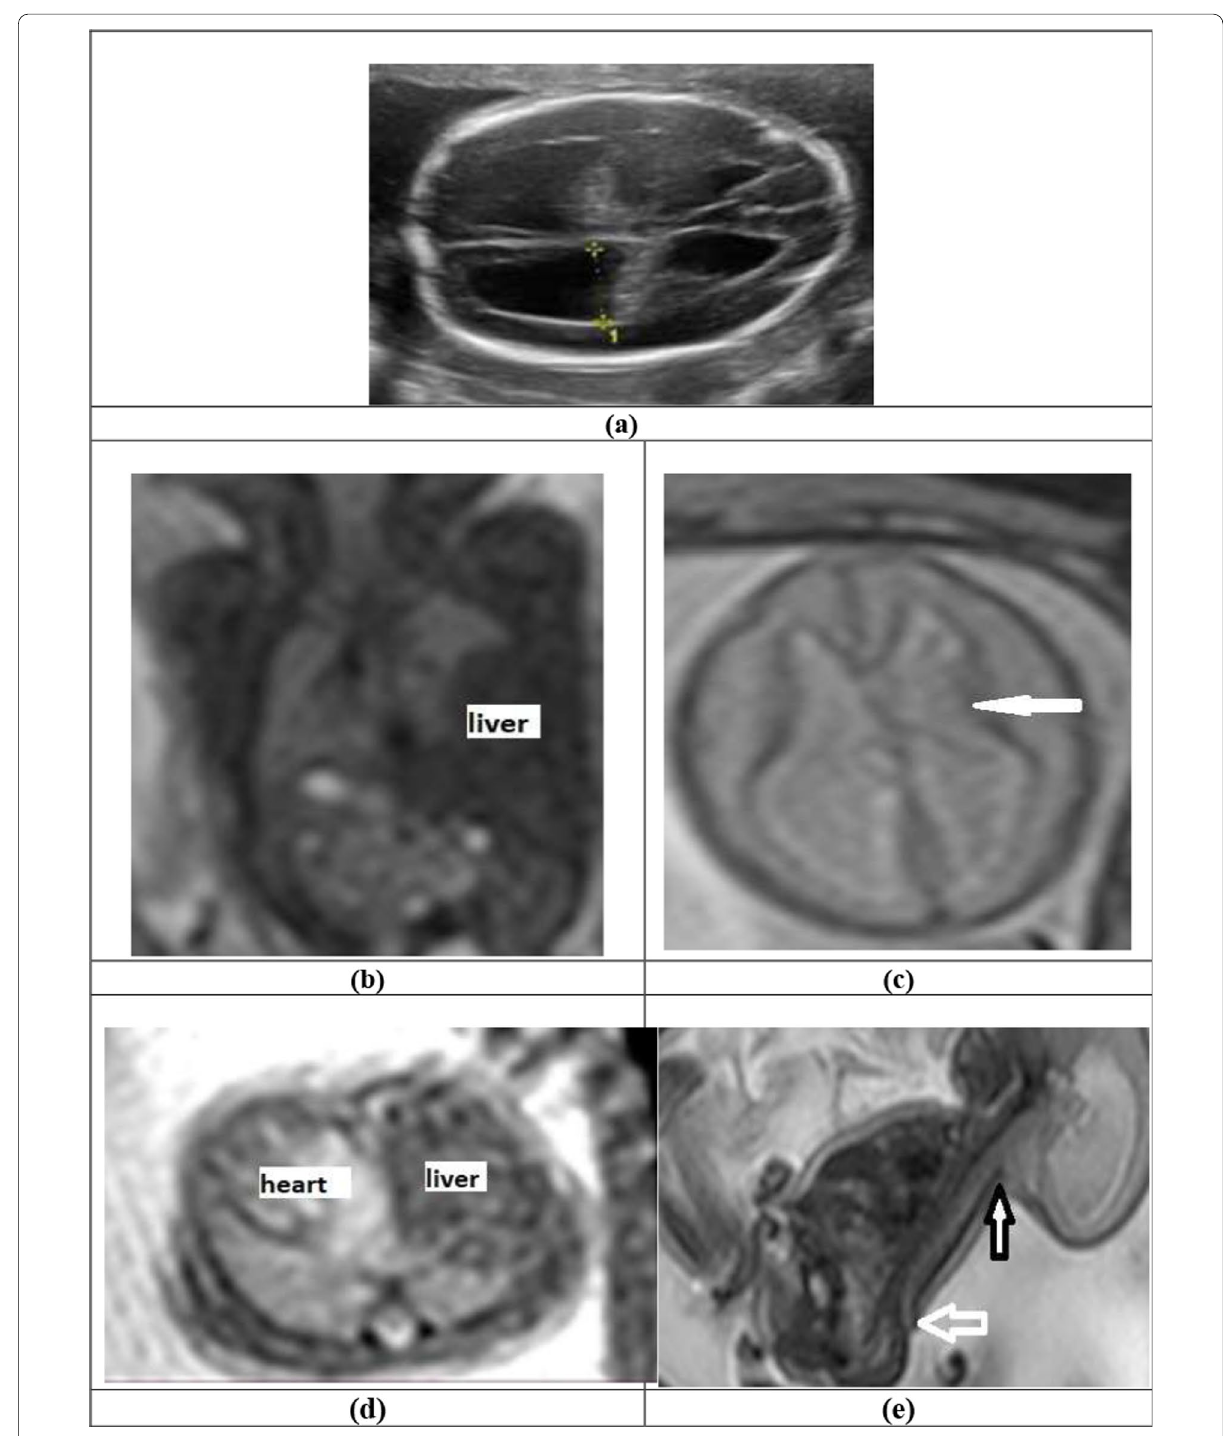
Fig. 4 28-year-old pregnant female at 25 weeks of gestation presented with polyhydramnios. Prenatal ultrasound: a revealed supra-tentorial ventricular dilation. Prenatal fetal MRI sequences revealed supra-tentorial ventricular dilation (white arrow) with shallow posterior fossa (black arrow) and spinal spina bifida (hollow arrow) at lumbosacral spine … Chiari II malformation, and congenital diaphragmatic hernia with herniating part of liver in the right hemi-thorax, b coronal T2 SSFSE sequence of the trunk, c axial T2 SSFSE sequence of the brain, d axial balanced steady-state free precession sequence (b-FFE) of the chest, e sagittal T2 SSFSE sequence of the spine. Diagnosis was Chiari II malformation and congenital diaphragmatic